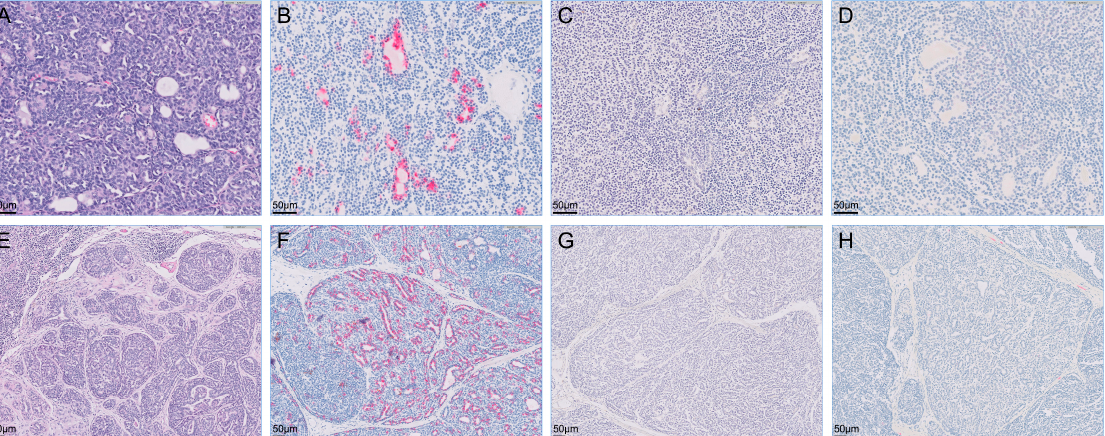
Figure 4. Microscopy of metastatic retroperitoneal mass ( A – D ) and enlarged right popliteal lymph node ( E – H ) visualized with hematoxylin ‒ eosin stain and immunohistochemistry. The retroperito- neal mass and right popliteal lymph node were intensely positive for cytokeratin 7 but were nega- tive for cytokeratin 20 and S100 proteins on immunohistochemistry. ( A ) Hematoxylin ‒ eosin stain; ( B ) immunohistochemistry for cytokeratin 7; ( C ) immunohistochemistry for cytokeratin 20; ( D ) im- munohistochemistry for S100s; ( E ) hematoxylin ‒ eosin stain; ( F ) immunohistochemistry for cy- tokeratin 7; ( G ) immunohistochemistry for cytokeratin 20; ( H ) immunohistochemistry for S100s.